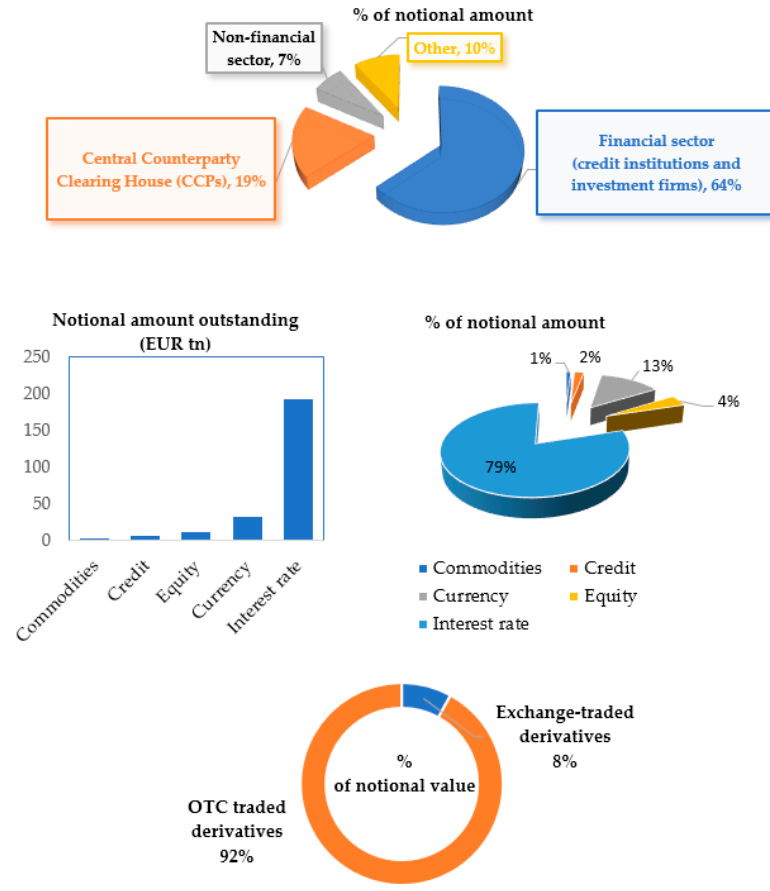
Figure 1. European derivatives market at a glance (2020). Note: Statistical data were provided by ESMA (2021). Statistics do not include data for the United Kingdom. Source: authors’ computa- tion.